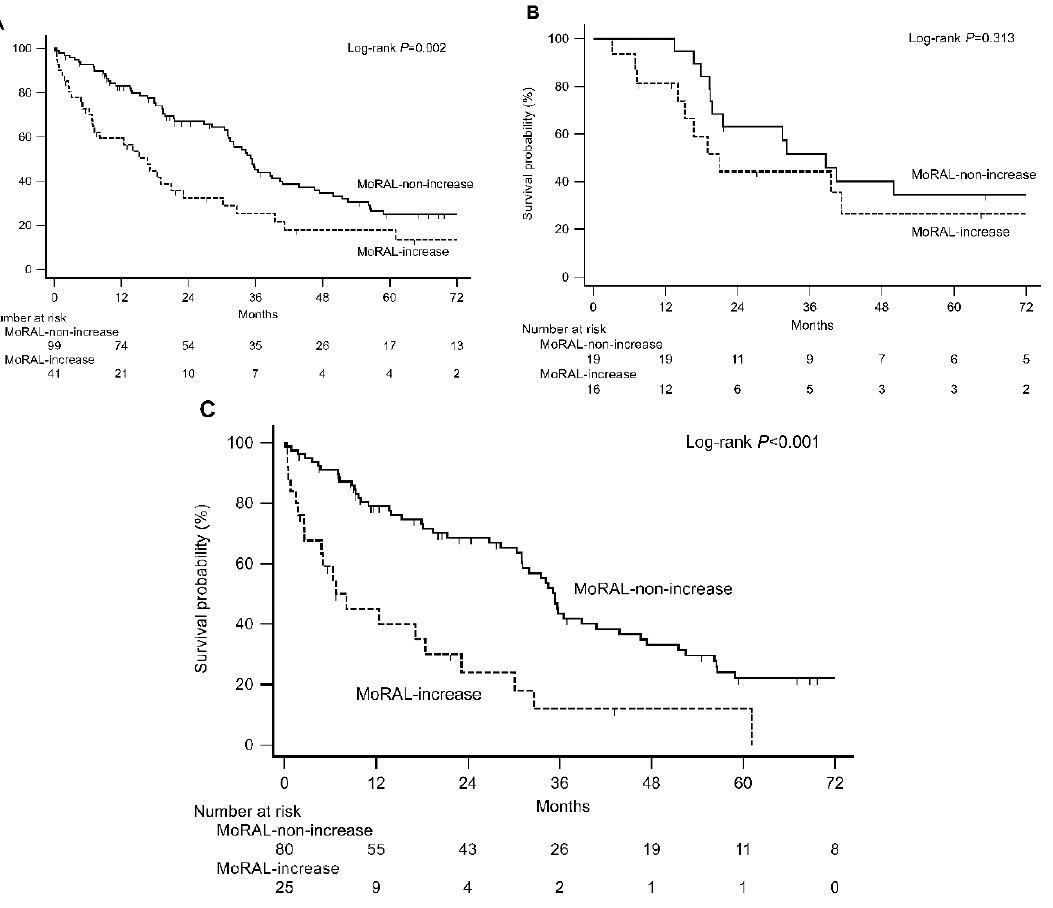
Figure 2. Prognostic significance of ΔMoRAL among the entire study population ( A ) and patients with baseline MoRAL score ≤89.5 ( B ) and >89.5 ( C ) in the hospital validation cohort.